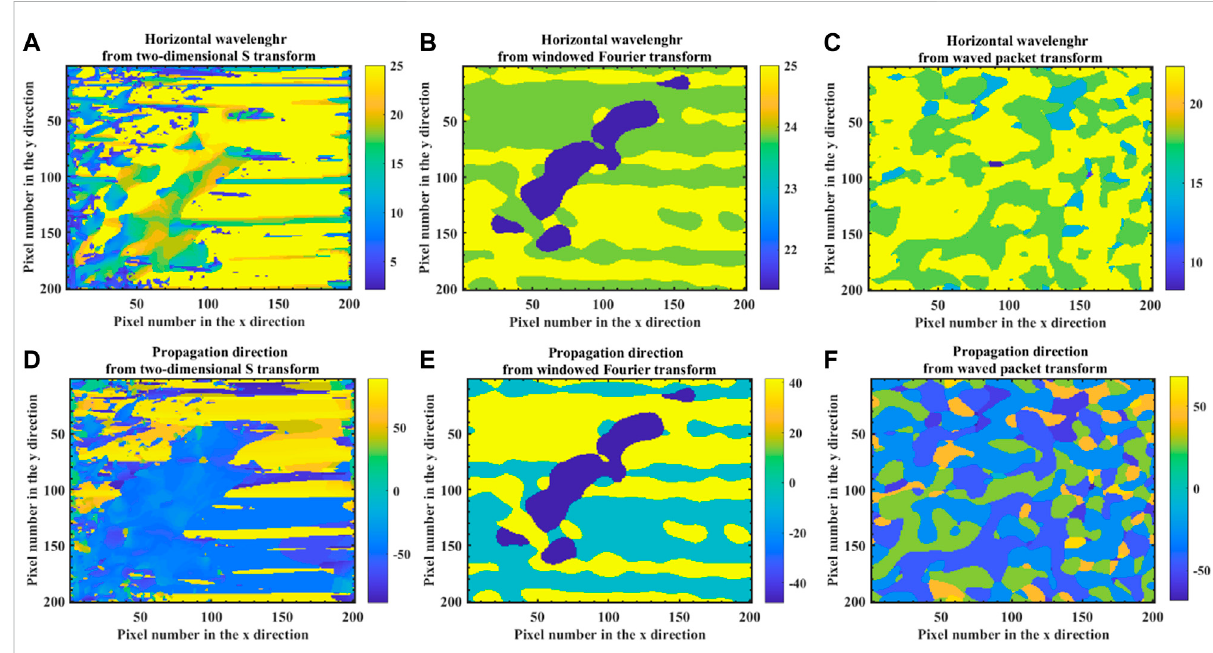
FIGURE 5 Horizontal wavelength internal wave without noise (Figure 4) calculated by (A) two-dimensional S transform, (B) windowed Fourier transform, and (C) waveletpackettransform,andpropagationdirectionofinternalwavewithoutnoise(Figure4)calculatedby (D) two-dimensionalStransform, (E) windowed Fourier transform, and (F) wavelet packet